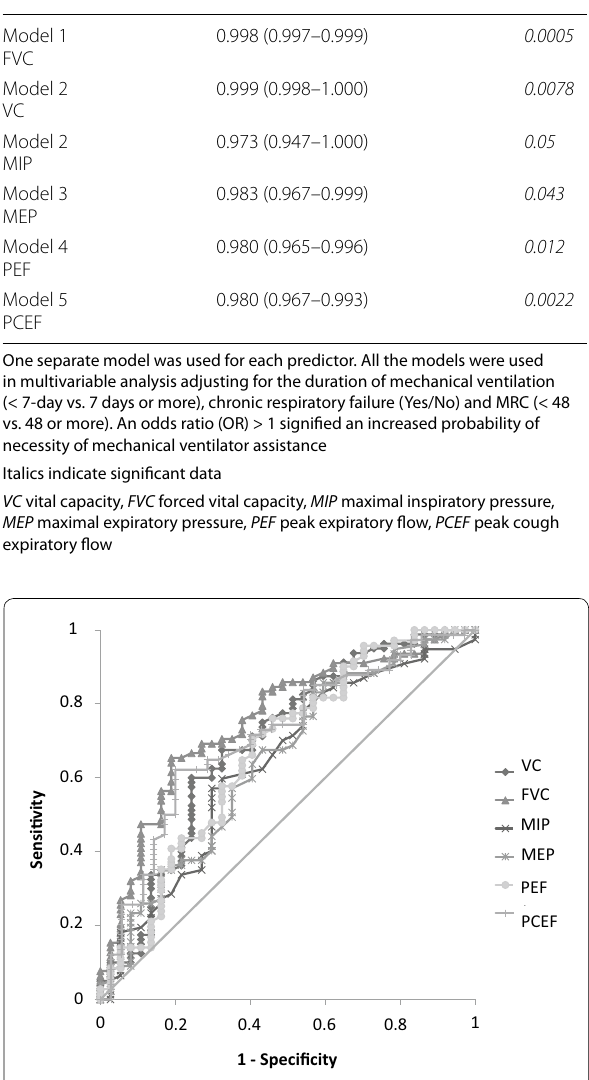
Fig. 2 Receiver operating characteristic (ROC) curves for data recorded before extubation: peak cough expiratory flow (PCEF), peak expiratory flow (PEF), forced vital capacity (FVC), slow VC, and maxi‑ mal inspiratory (MIP) and expiratory (MEP) mouth pressures. AUC, area under the ROC curve